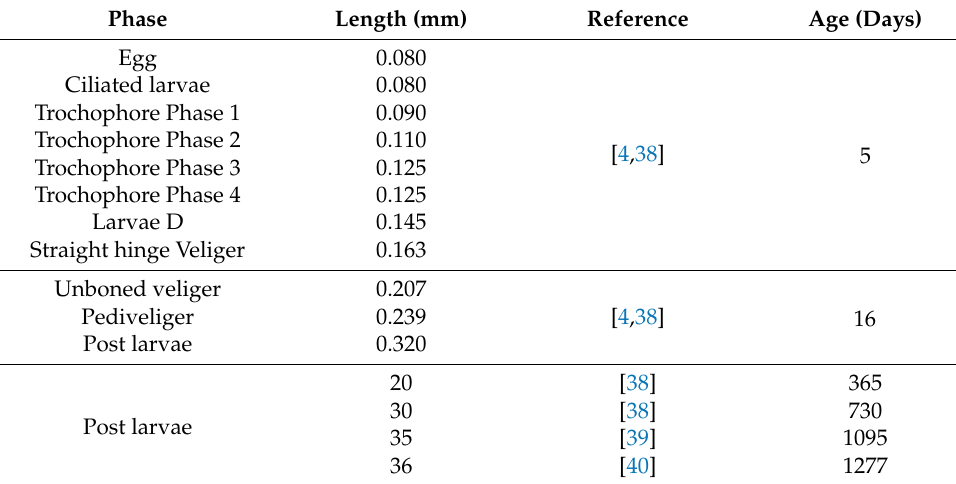
Table 3. Age and shell length of golden mussel.